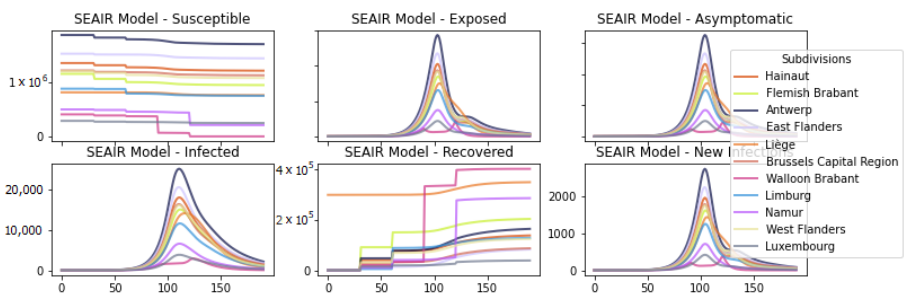
Figure 13. Plots of susceptible, exposed, asymptomatic, infected, recovered, and newly infected individuals per day for each region of the SEAIR model with the best vaccination plan